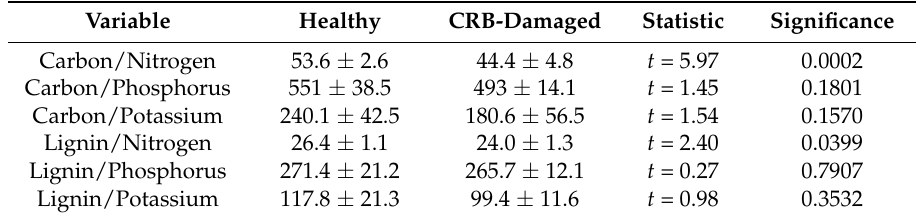
Table 4. The influence of coconut rhinoceros beetle (CRB) herbivory on senesced coconut leaflet chemical traits. n =